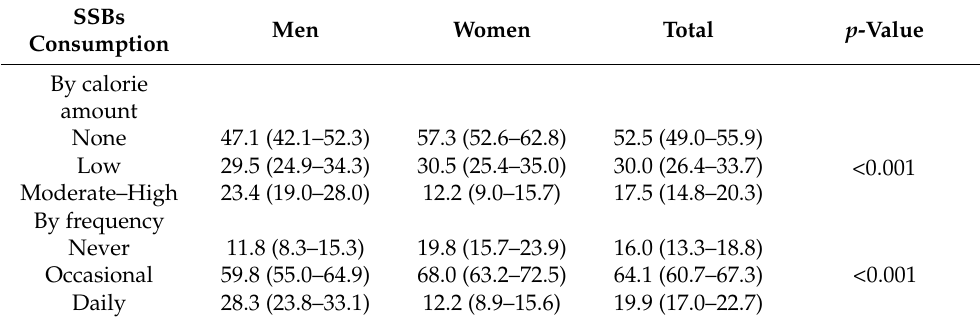
Table 2. Prevalence of SSBs consumption in the sample in general and stratified by sex.